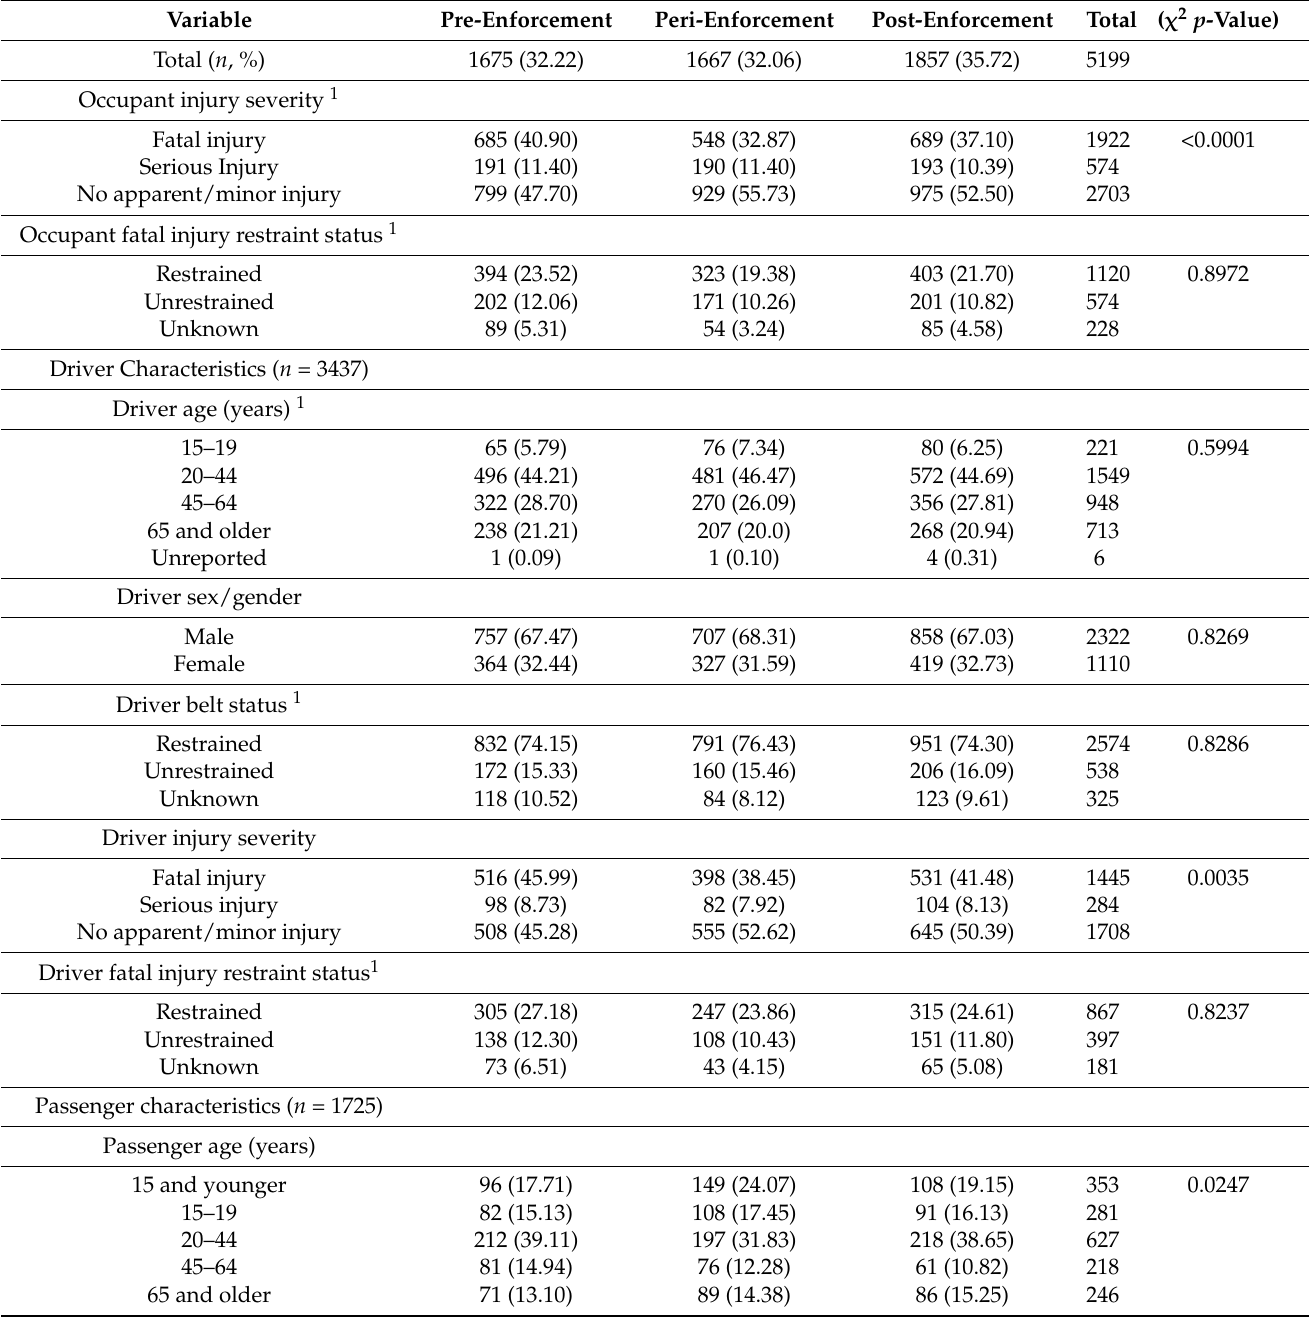
Table 1. Population characteristics of fatal crashes in the Upstate and Long Island regions of New York State by Click It or Ticket Enforcement Periods, FARS